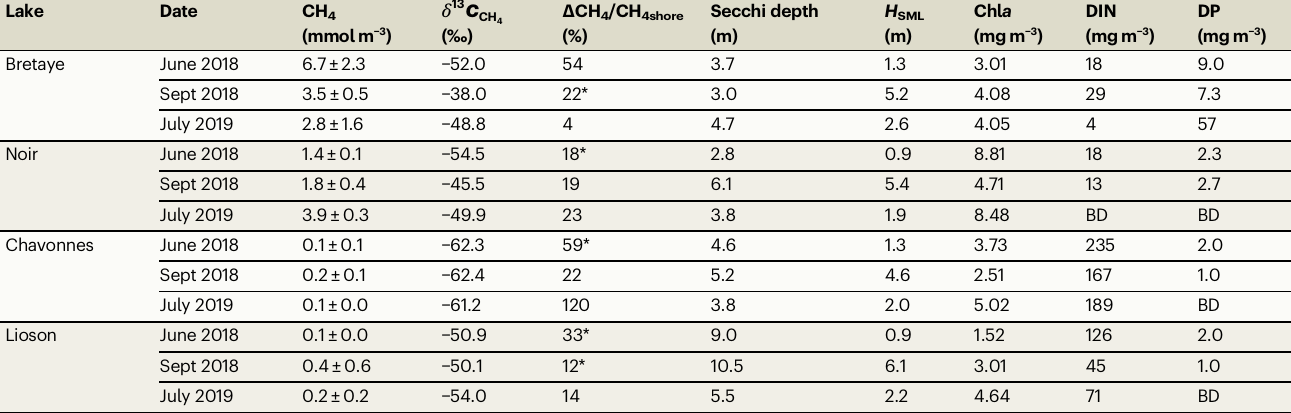
Table 1 | General characteristics of surface waters across the studied lakes Lake